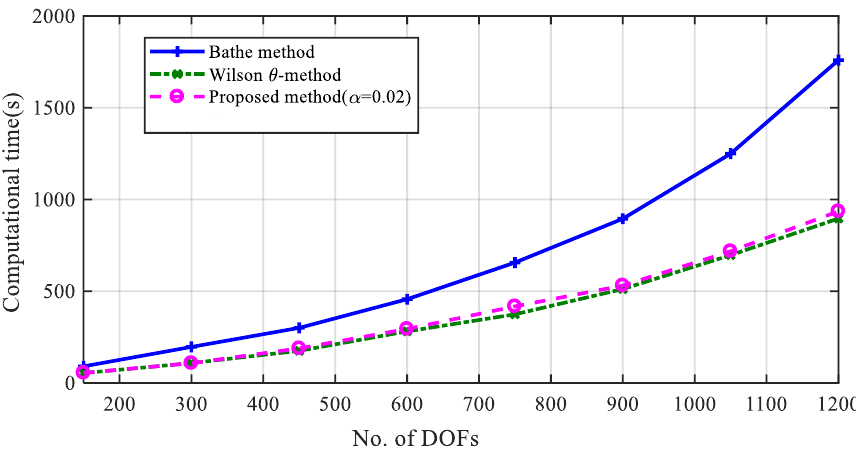
Figure 23. Variation of computational time versus the number of degrees of freedom (DOFs) of the model.